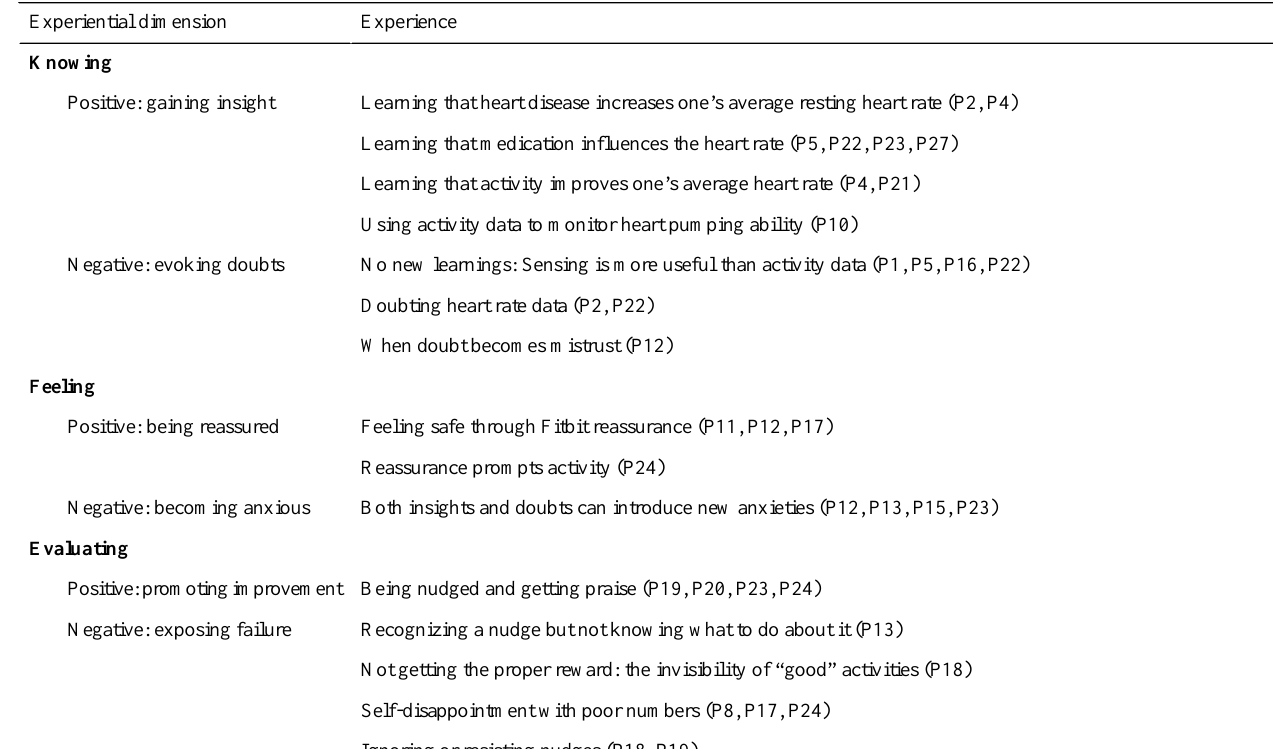
Table 2. Dimensions of how patients experienced activity tracking related to their